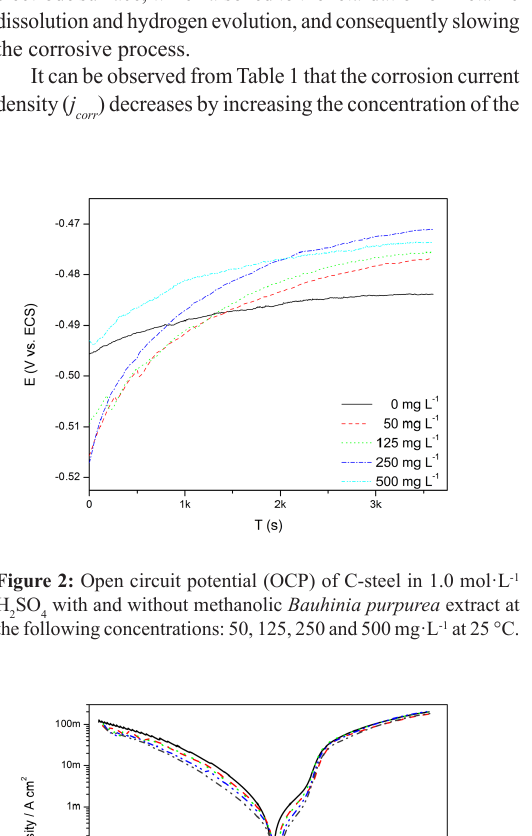
Figure 3: Polarization curve of C‑steel in 1.0 mol·L -1 H and without methanolic Bauhinia purpurea extract at the following concentrations: 50, 125, 250 and 500 mg·L -1 at 25 °C.